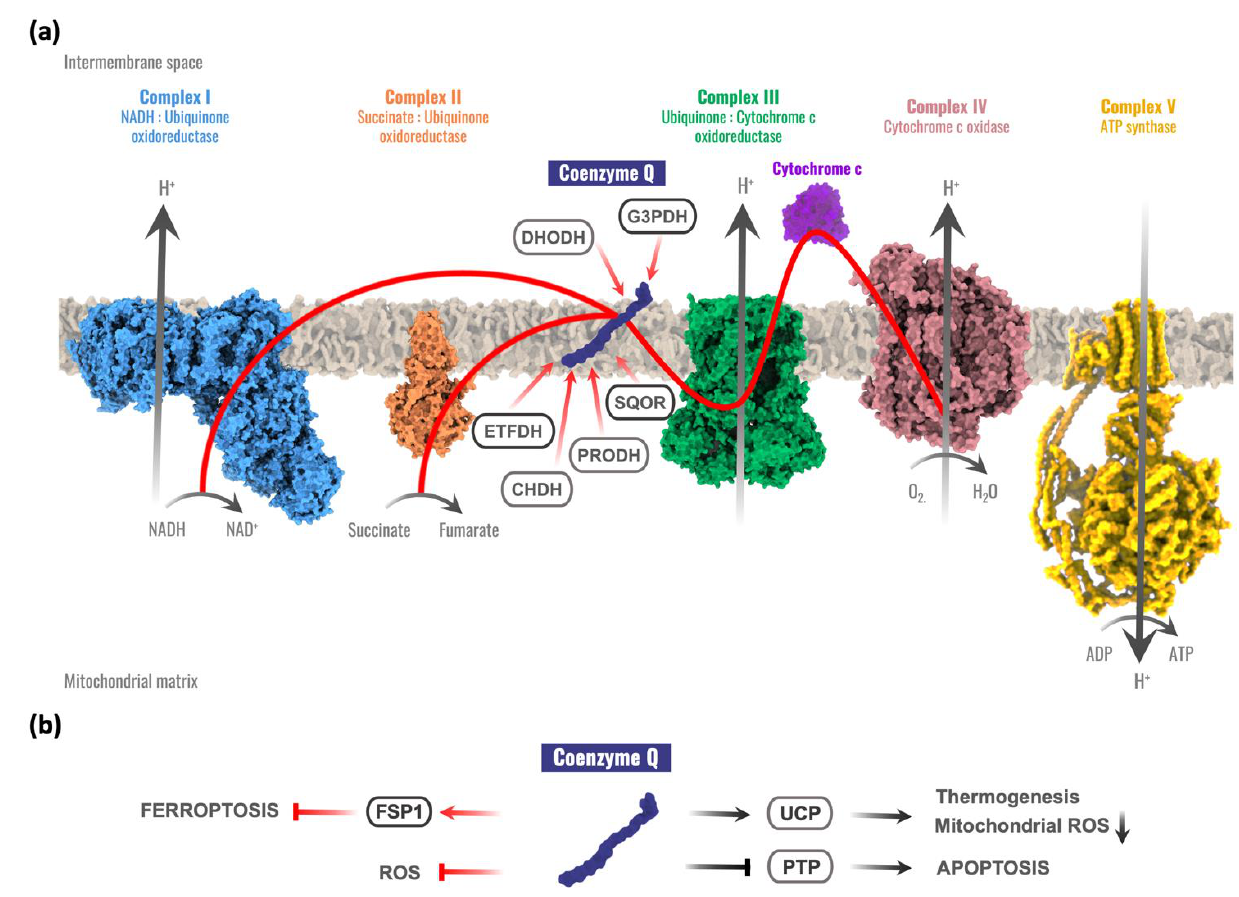
Figure 1. Coenzyme Q functions in the cell. ( a ) The role of coenzyme Q (CoQ) in the mitochondrial respiratory chain and its relationships with other mitochondrial enzymes. Red arrows represent electron flow. CoQ accepts electrons from complex I and complex II, sulfide:quinone oxidoreductase (SQOR), proline dehydrogenase and proline dehydrogenase 2 (PRODH), choline dehydrogenase (CHDH), mitochondrial glycerol-3-phosphate dehydrogenase (G3PDH), dihydroorotate dehydrogenase (DHOH), and electron transport flavoprotein dehydrogenase (ETFDH). ( b ) CoQ extramitochondrial functions. Red arrows represent electron flow. FSP1 = Ferroptosis Suppressor Protein 1; UCP = Uncoupling Protein; PTP = Permeability Transition Pore; ROS = Reactive Oxygen Species.